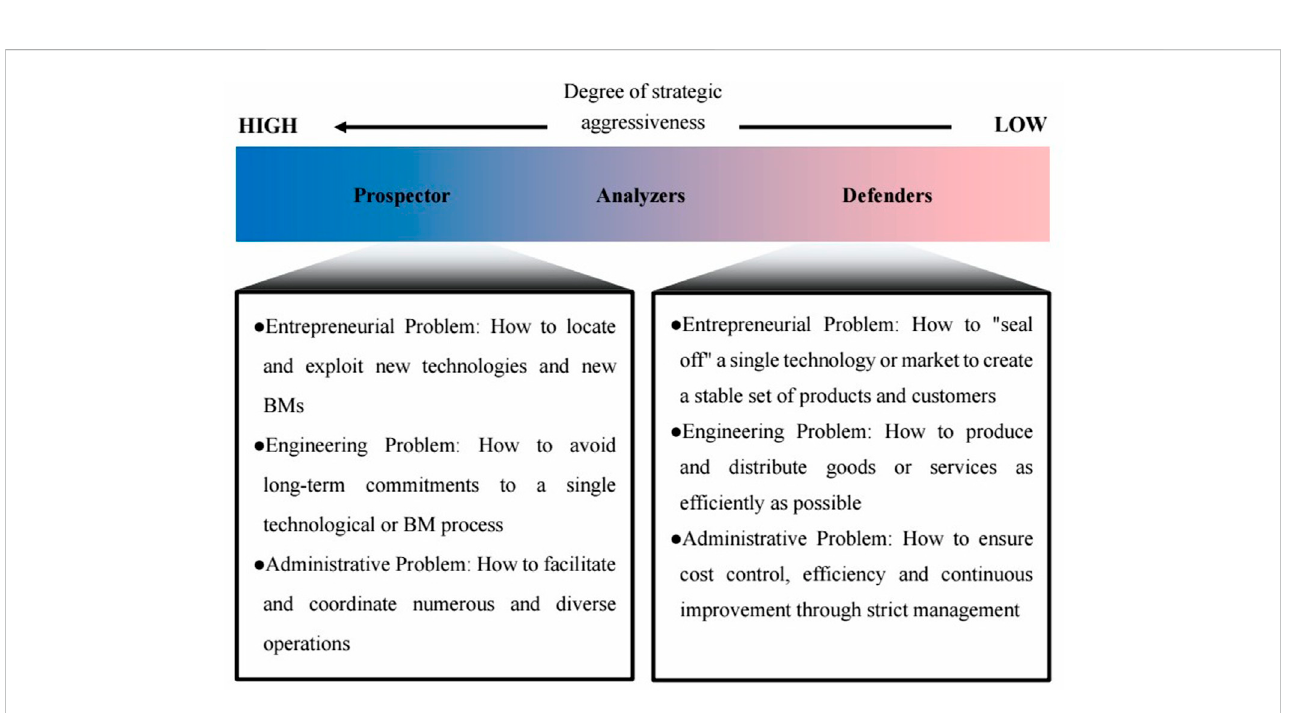
FIGURE 1 A continuum model of the degree of strategic